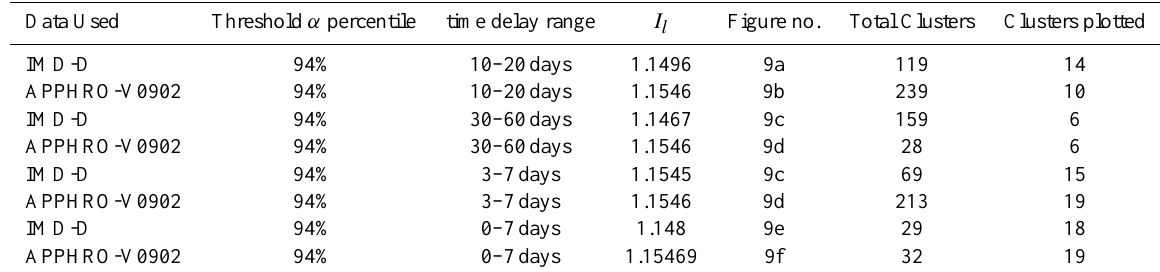
Data Used Figure no. Total Clusters Clusters plotted